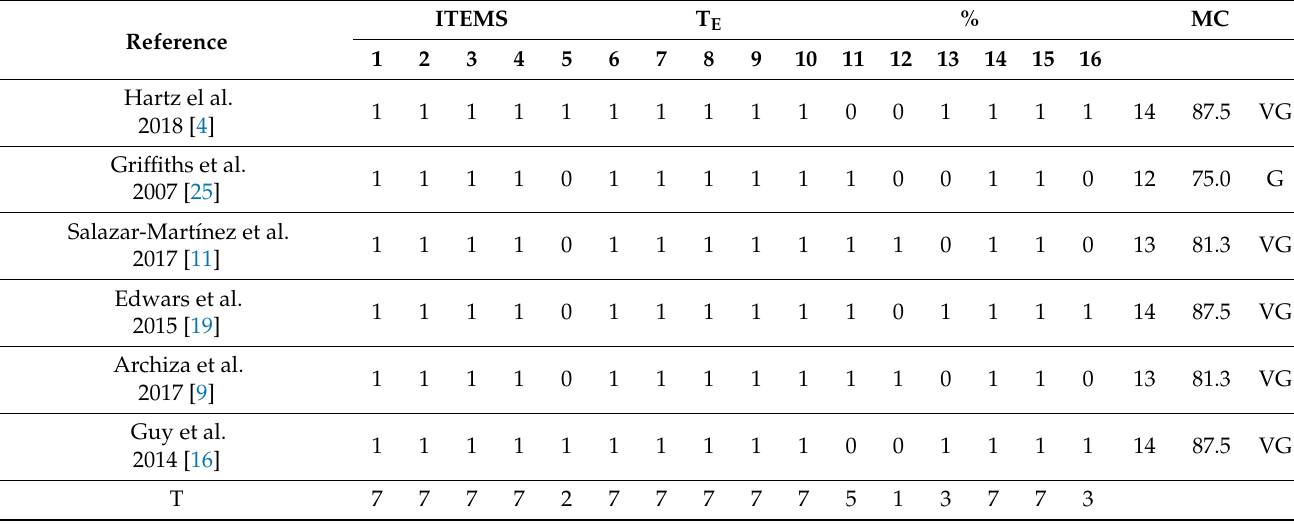
Table 2. Results of the quality assessment.